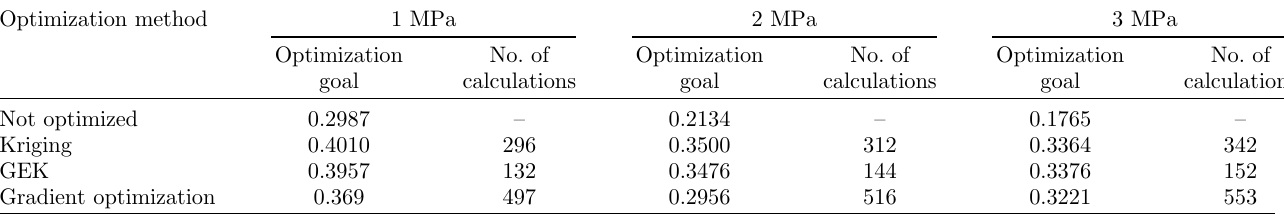
Table 7. Optimization methods under hydrostatic pressure. Optimization